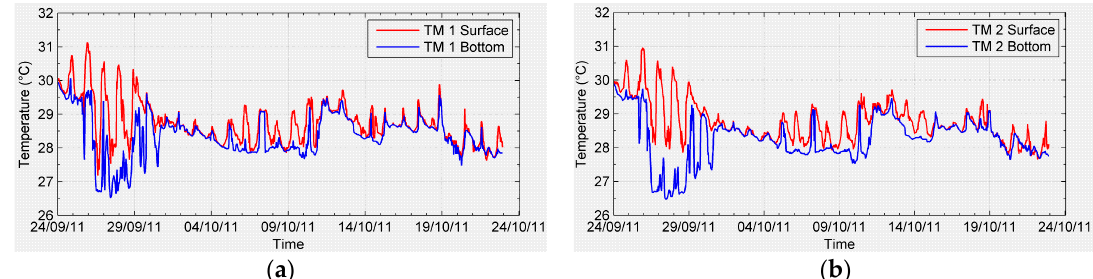
Figure 8. Time series of seawater temperature measured in front of the CTPALM. ( a ) Mooring TM 1; ( b ) Mooring TM 2.